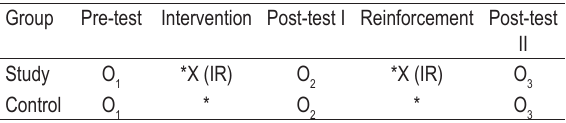
TABLE 1. Research design of the